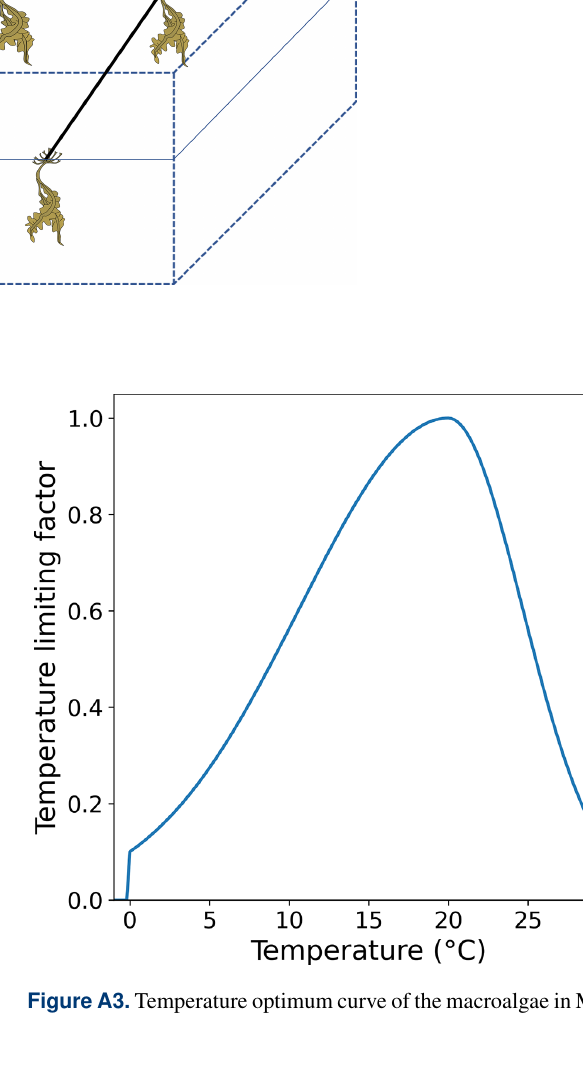
Earth Syst. Dynam., 14, 185–221,